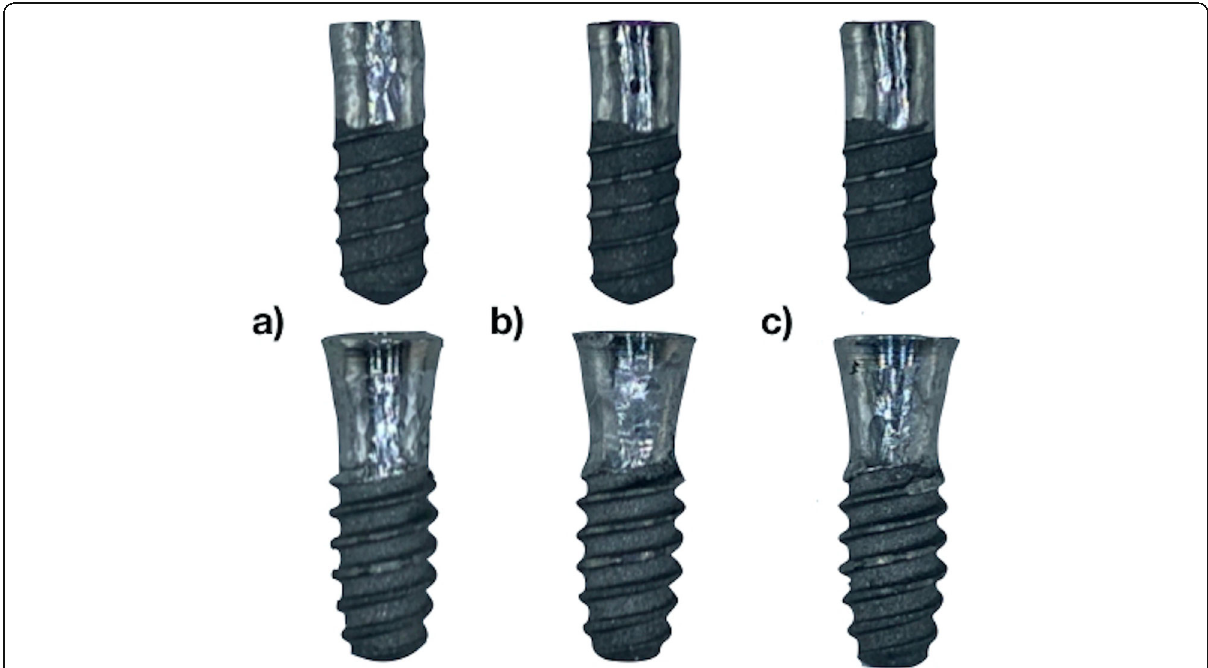
Fig. 1 Bone-level and machined collar (tissue-level) implants with a diameter of 3.5 mm after performing a manual implantoplasty. a After using an oval tungsten carbide bur; b after surface polishing using a brown silicon carbide polisher; c after surface polishing using a green silicon carbide